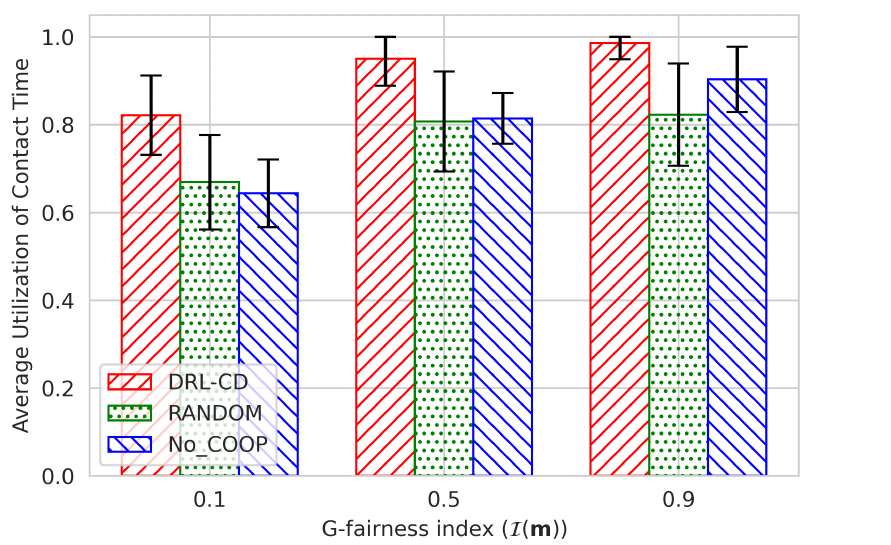
Figure 5. G-fairness index vs. average contact-time